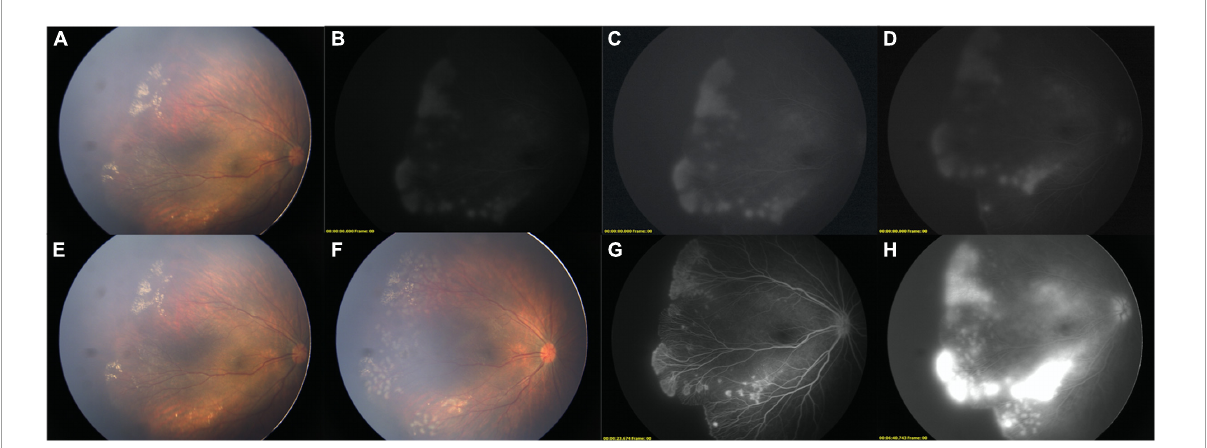
FIGURE1 Two-step FFA of a FEVR child. (A) Color image before FFA (OD). (B,C) [adjusted version of (B) ], LD-FFA image showed supernumerous vascular branching, NV, fluorescein leakage, peripheral avascular zone. (D) adjusted version of late phase of LD-FFA, fluorescein leakage remained. (E) Color image after LD-FFA. Comparing with (A) , no obvious media opacity was noted. (F) After laser photocoagulation, the laser spots and retinal vessels are clearly displaced. (G) Step-two RD-FFA shown clearly all the detailed retinal vessels and revealed more about the absence of the FAZ, and bulbous vascular terminals. (H) Late phase of RD-FFA, severe fluorescein leakage was noted.